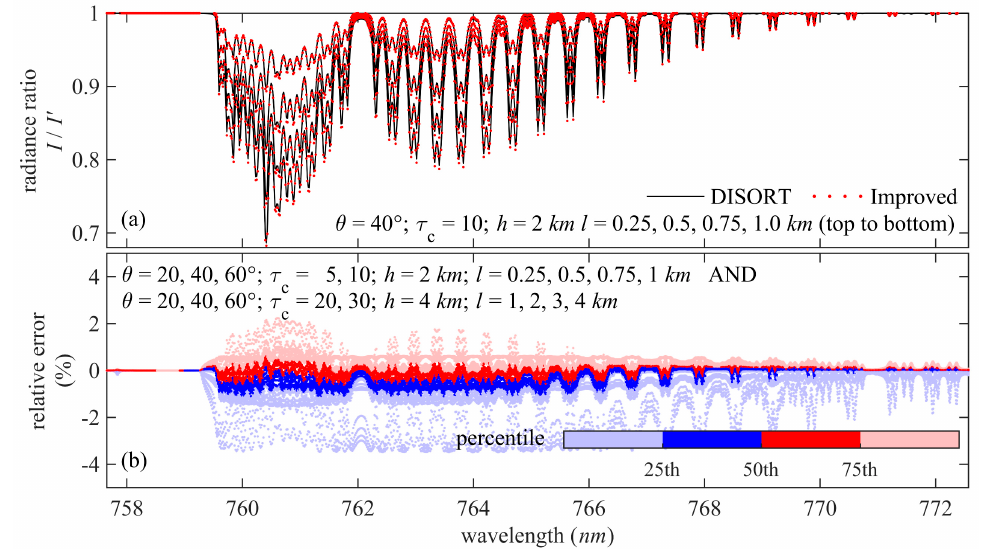
Figure 10. Comparison of the simulated radiance ratio from the parameterization and DISORT at different cloud geometrical thicknesses. ( a ) The radiance ratio inside the oxygen A-band decreases with the thinning cloud geometrical thickness. ( b ) The relative error of the radiance ratio inside the oxygen A-band. The percentiles are estimated from 24 thin clouds and 24 thick clouds.